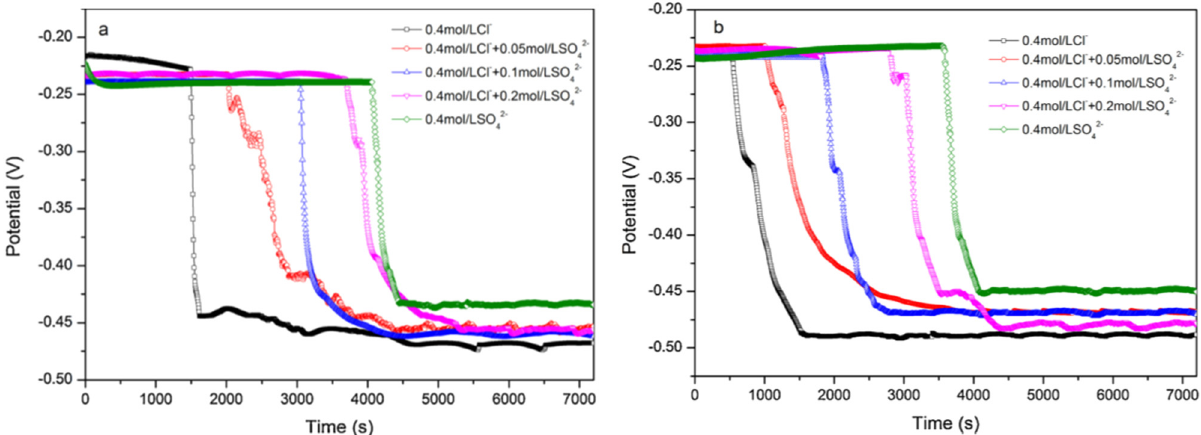
Figure 4: Evolutions of corrosion potentials of steel specimens in the solutions: ( a ) with the Mg – Al LDHs; ( b ) without the Mg – Al LDHs [ 85 ] .